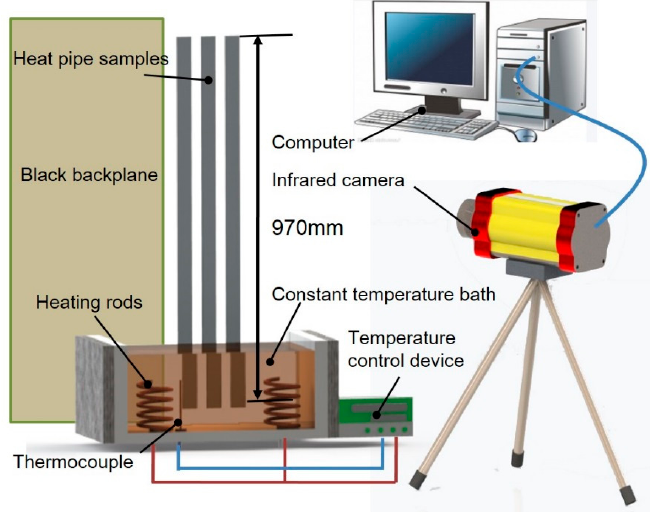
Figure 4. The test setup to evaluate heat pipe temperature uniformity.